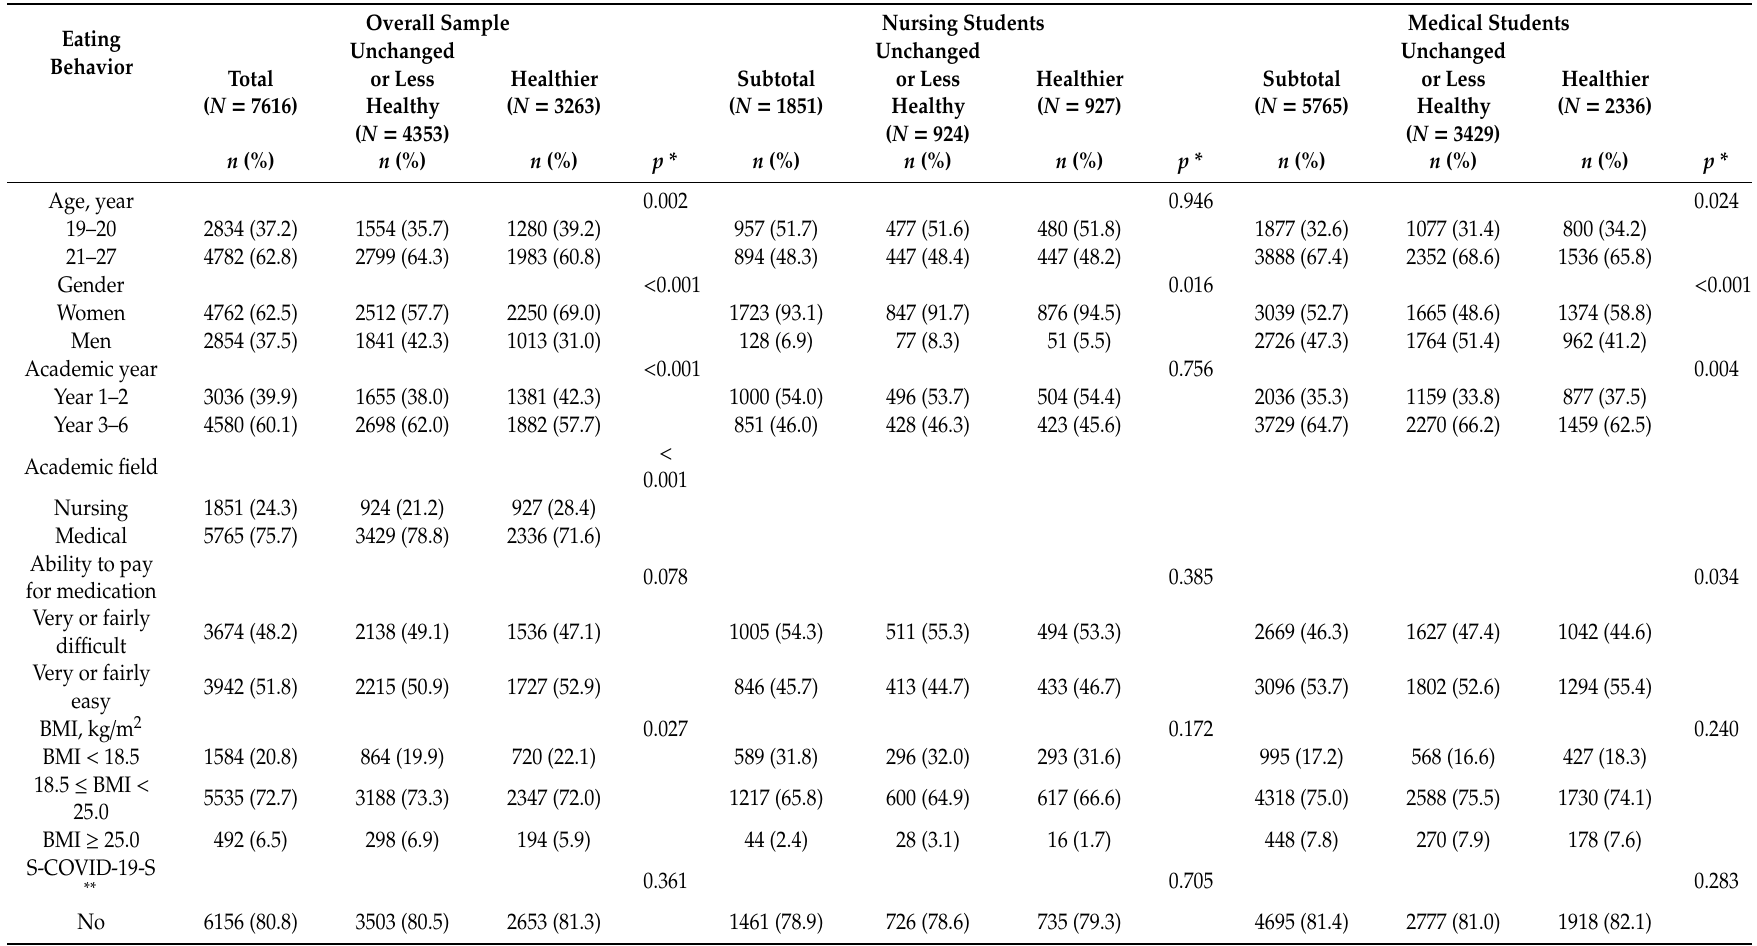
Table 2. Participants’ characteristics and eating behavior change in the overall sample, nursing, and medical